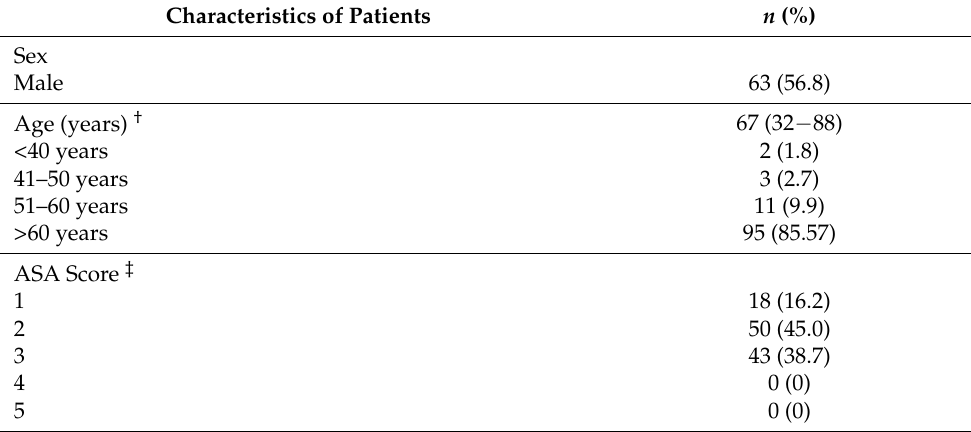
Table 1. Clinical-pathological and laboratory characteristics of